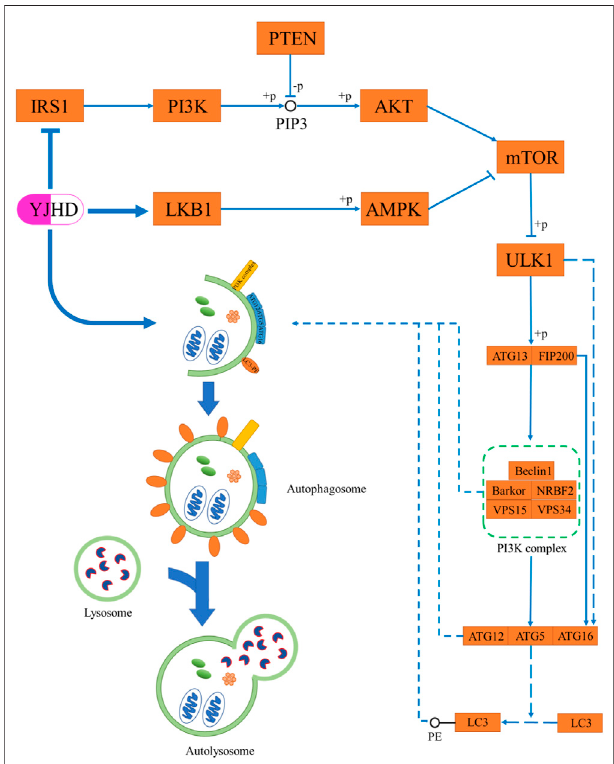
FIGURE 9 | Schematic diagram of autophagy